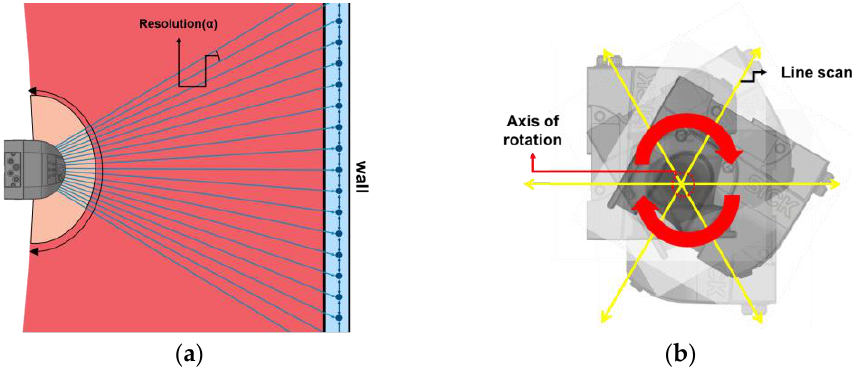
Figure 3. 3D point cloud data collection using the 2D LiDAR sensor. ( a ) Scan range of the 2D LiDAR sensor; ( b ) 360° rotation of the 2D LiDAR sensor.